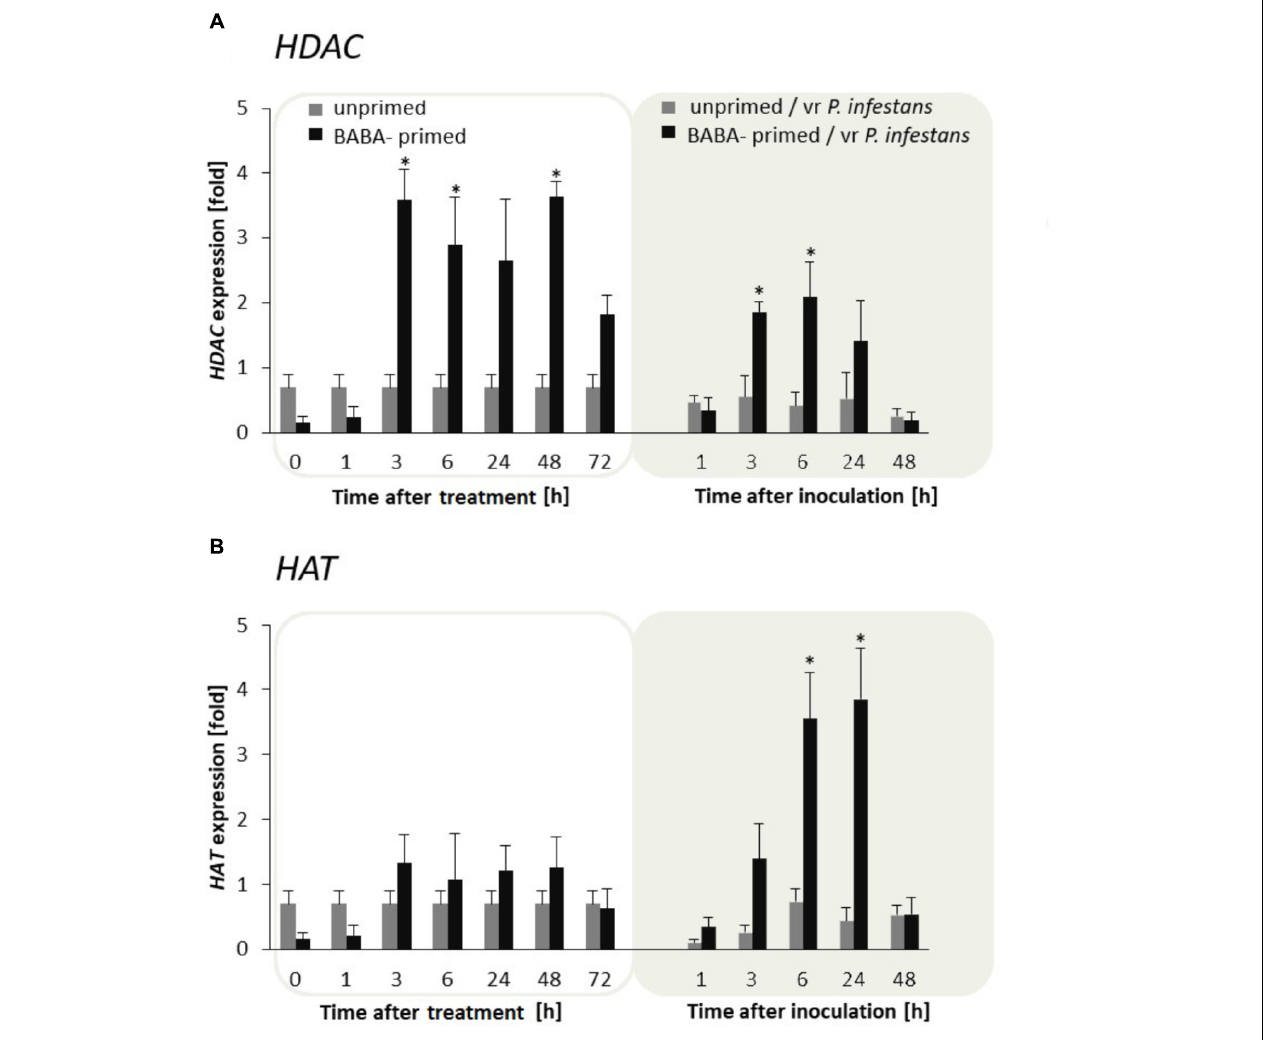
FIGURE 4 | Expression patterns of histone acetylation and deacetylation upon exposure to BABA and biotic stress. Transcriptional analysis of HDAC (A) and HAT (B) gene expression in BABA-primed leaves of potato plants followed by challenge inoculation with P. infestans (at 72 h after BABA treatment). Analyses were performed at 0–48 h after 5 mM BABA exposure (white background) and 1–48 hpi after challenge inoculation (gray background). Light columns refer to unprimed, while dark columns - to primed plants. Values represent means of data ± SD of at least three independent experiments. Asterisks indicate values that differ significantly from unprimed (water treated) or unprimed and P. infestans inoculated potato leaves at P < 0.05 ( ∗ ),